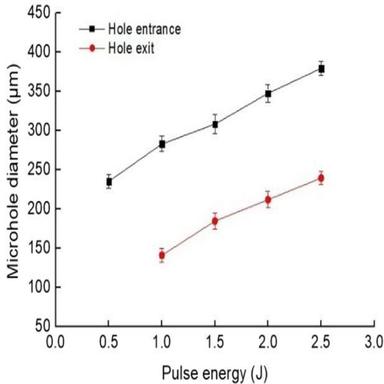
Influence of the laser pulse energy on the hole entrance and exit diameters drilled using 50 laser pulses.